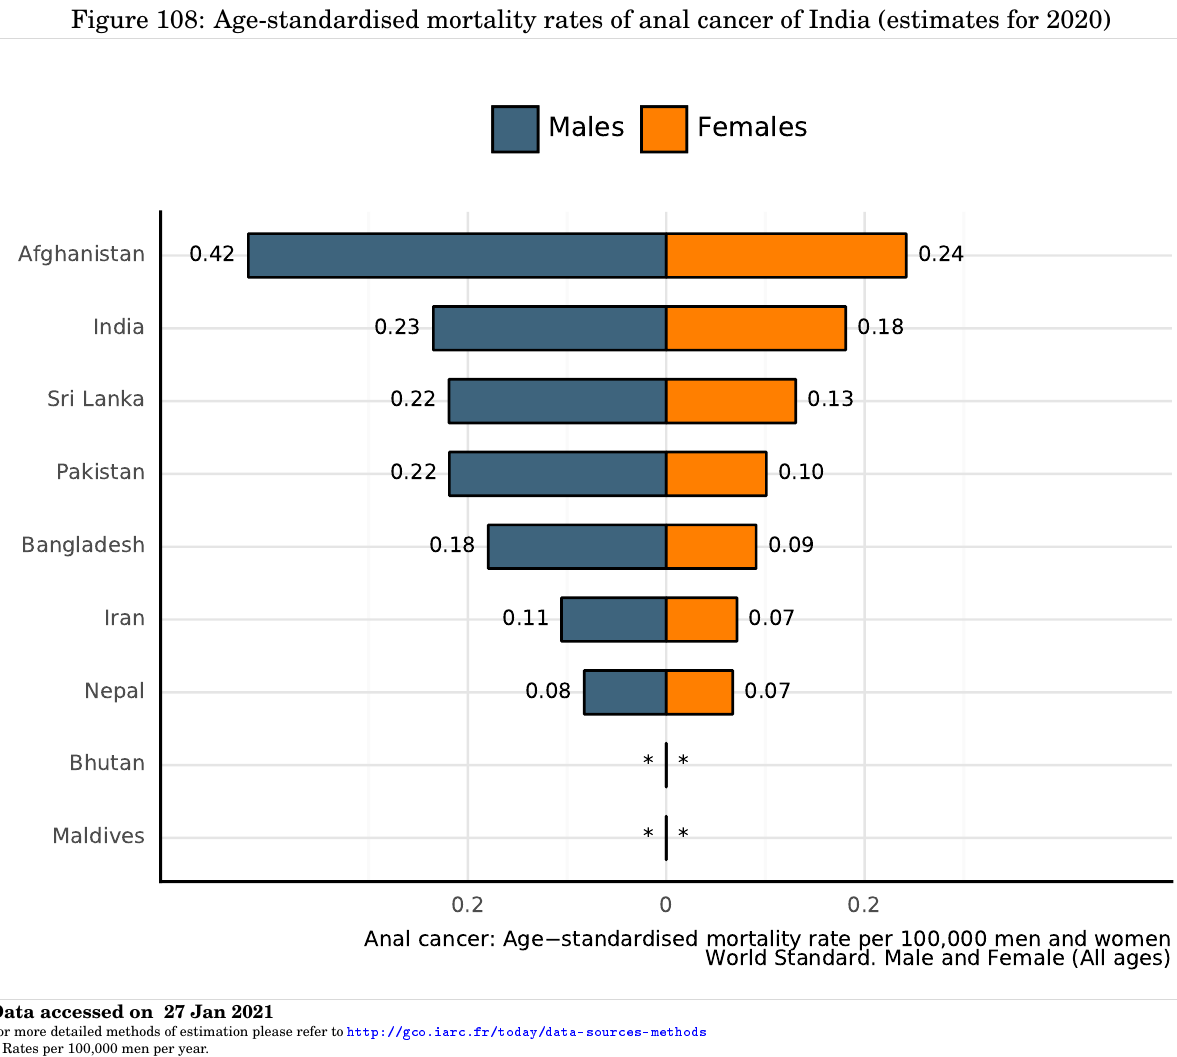
Figure 108: Age-standardised mortality rates of anal cancer of India (estimates for 2020)